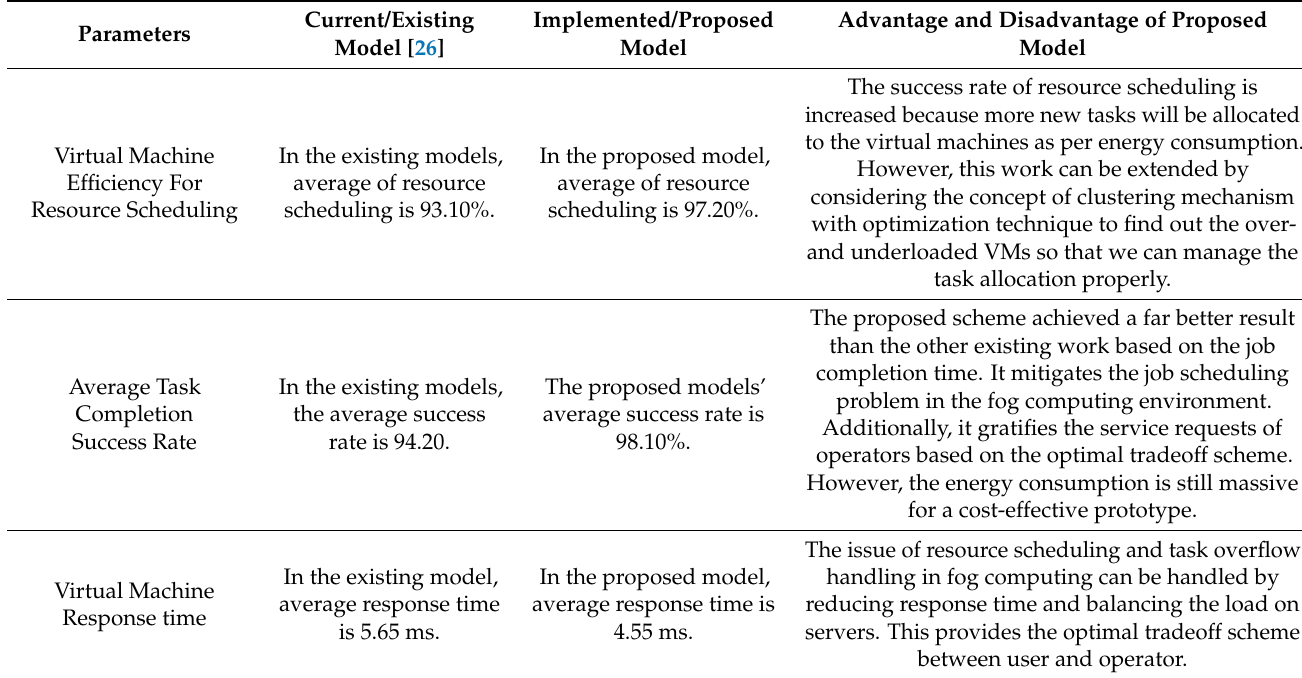
Table 1. Comparison of Parameters with Advantages and